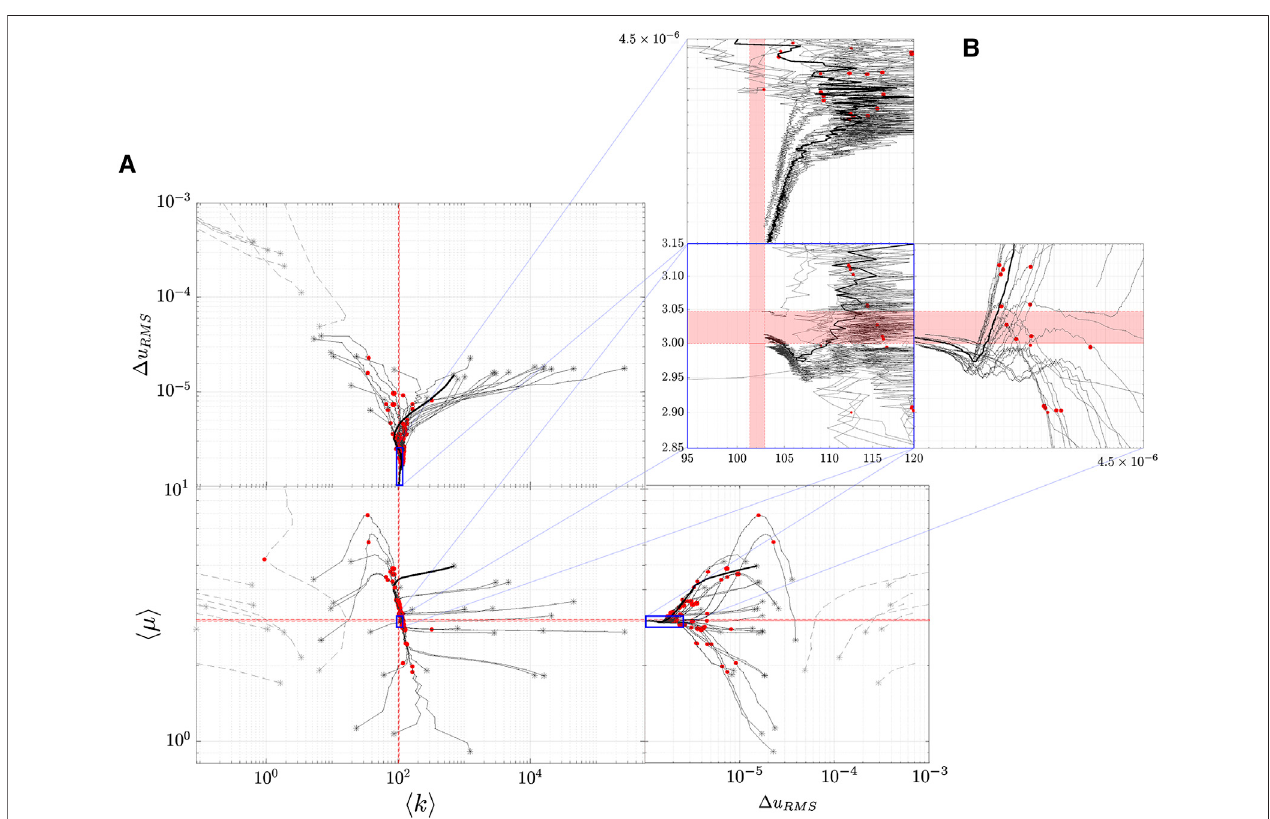
FIGURE 12 | Lower dimensional representation of the inference trajectories. Note that because two properties are being reconstructed, the lower dimensional representation is 2-dimensional. This plot conveys the trajectories through an orthographic projection. (A) shows a large region of ( 〈 k 〉 , 〈 μ 〉 ) -space, including starting points of the trajectories represented by asterisks. Right and top panels represent root mean square values for converging trajectories. Some diverging trajectories are also shown-theyaredashed and lighter.Thesingle thicktrajectoryistheoneusedfor Figure11 .Smalland largered markersrepresentpointswhere thedescent strategy changed. The light red horizontal and vertical regions are the critical strips laying between the background property values and the ground truth mean values. Note that, as before, scales are all logarithmic. (B) is zoomed into the blue squares located in the fi gures described above. The shaded red areas represent the region betweenthebackgroundpropertyvalue, μ 0 or k 0 ,andthemeanvalueofthegroundtruthdistributions, 〈 μ 〉 GT or 〈 k 〉 GT .Notethatintheseplotsthescaleshavechanged to be linear. Discussion of trends is in the text.